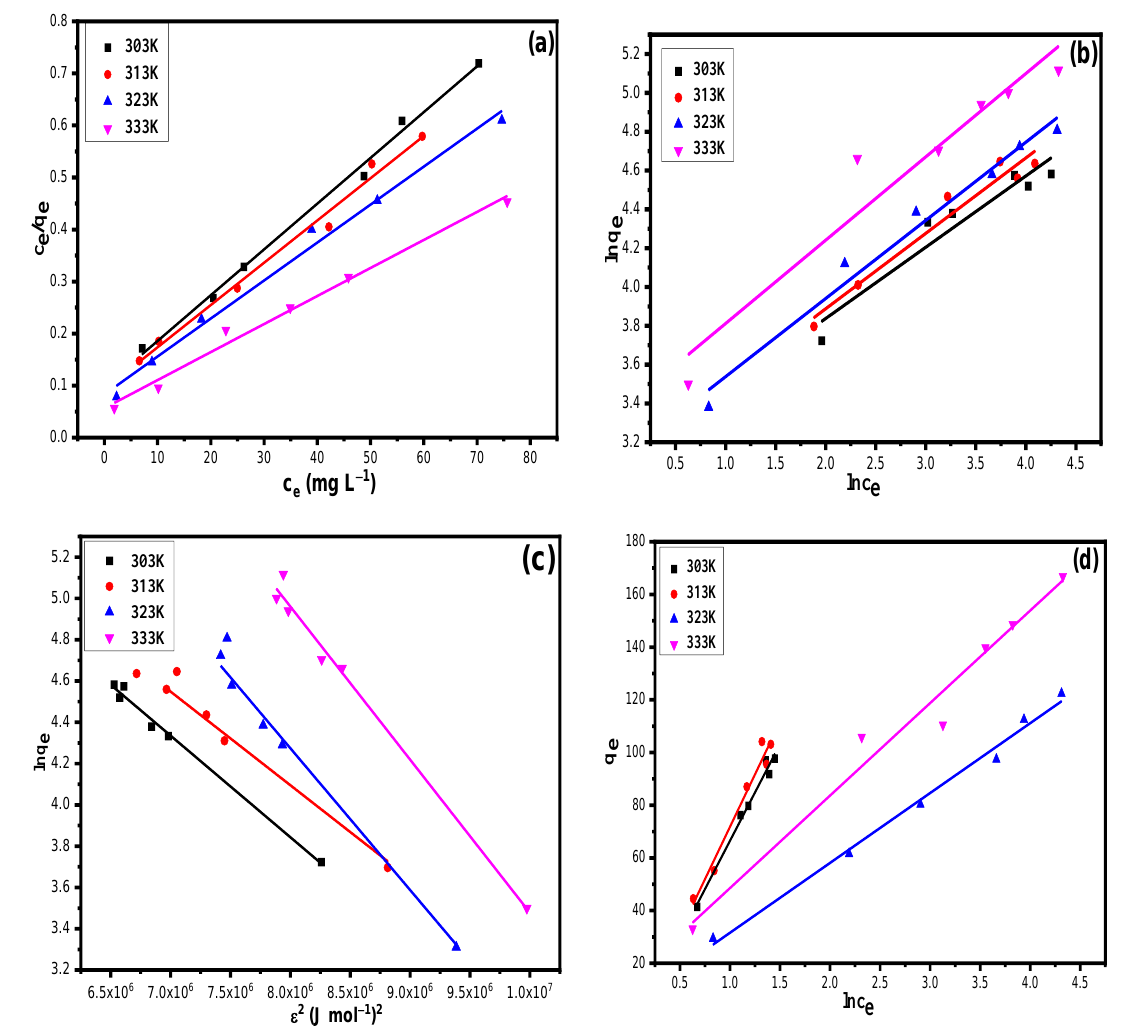
Figure 7. ( a ) Langmuir, ( b ) Freundlich, ( c ) D–R and ( d ) Temkin adsorption isotherms for Pb (II) on XGFO at 303 K, 313 K, 323 K and 333 K (adsorbent dose = 11 mg and pH 4.8). Table 1. Adsorption isotherm data obtained through the linear regression method for removal of Pb (II) onto XGFO BNC.